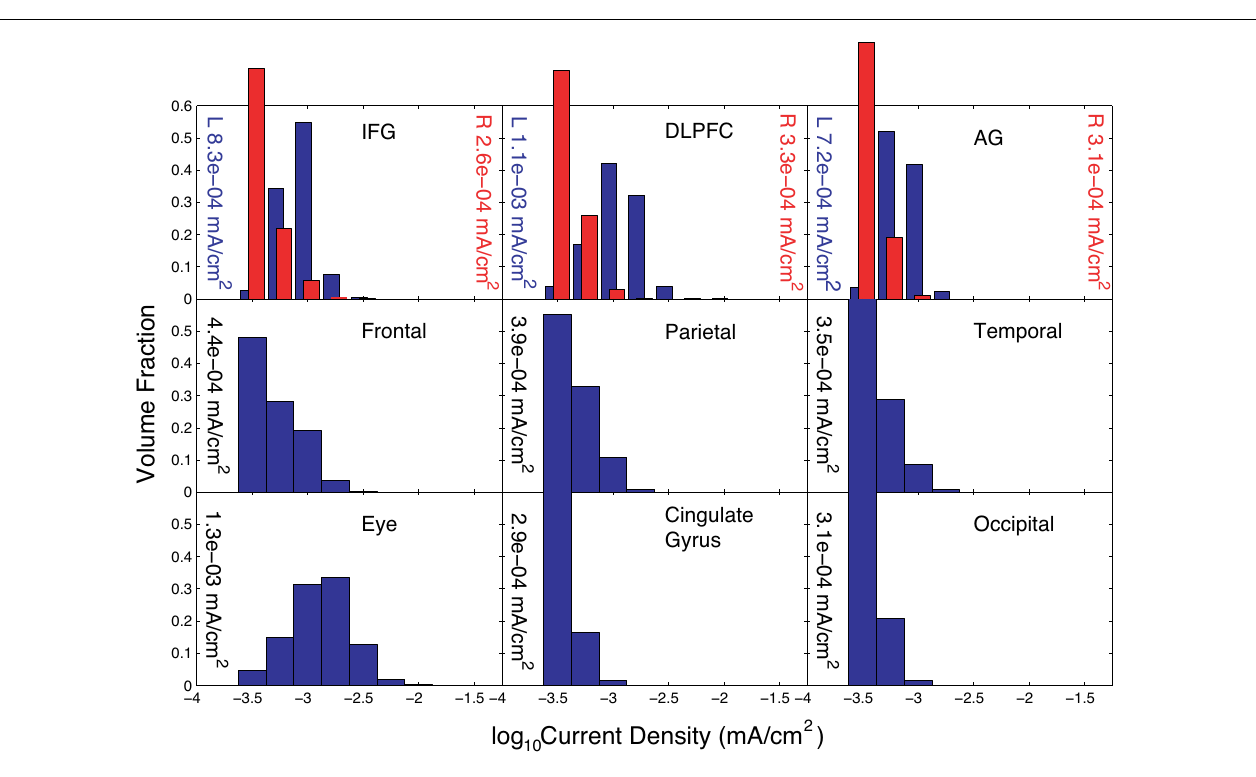
(IFG), dorsolateral prefrontal cortex (DLPFC), and angular gyrus (AG), respectively. For the IFG, DLPFC, and AG, current density distributions are shown separately for left (blue) and right (red) structures, with median values shown on either side of each plot.